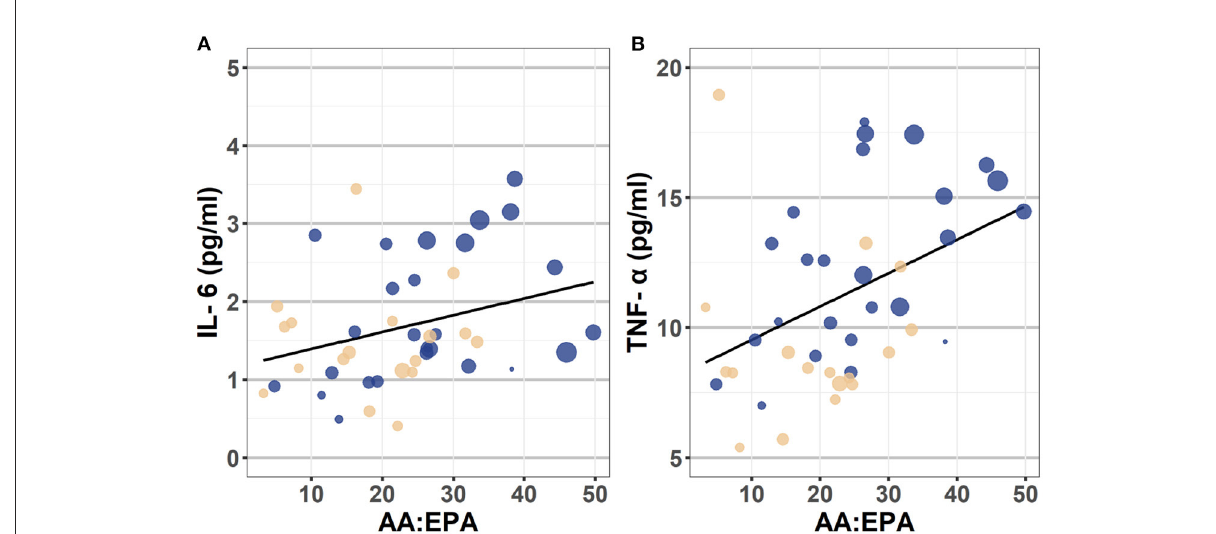
FIGURE2 Scatterplot depicting the association between AA:EPA ratio and IL-6 (Panel A) and TNF- α (Panel B). These scatterplots depict the bivariate association between the AA:EPA and plasma concentrations of IL-6 (on the left) and TNF- α (on the right). The individual data points are color coded to reflect participant ADHD status (Yellow = Control, Blue = heightened ADHD symptoms). The diameter of each circle reflects participant pre-pregnancy BMI values, with larger circles indicating individuals with higher BMI than smaller diameter circles. Though BMI was treated as a continuous variable in analyses, they were categorized into following categories for the purposes of this plot: Healthy = 18.5–24.9, Overweight = 25.0–29.9, and Obese = 30.0 and above categories. AA, arachidonic acid; EPA, eicosapentaenoic acid; IL-6, interleukin-6; TNF- α , tumor necrosis factor-alpha; BMI, body mass